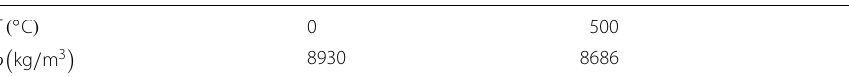
Table 2 Temperature dependent density of pure cupper